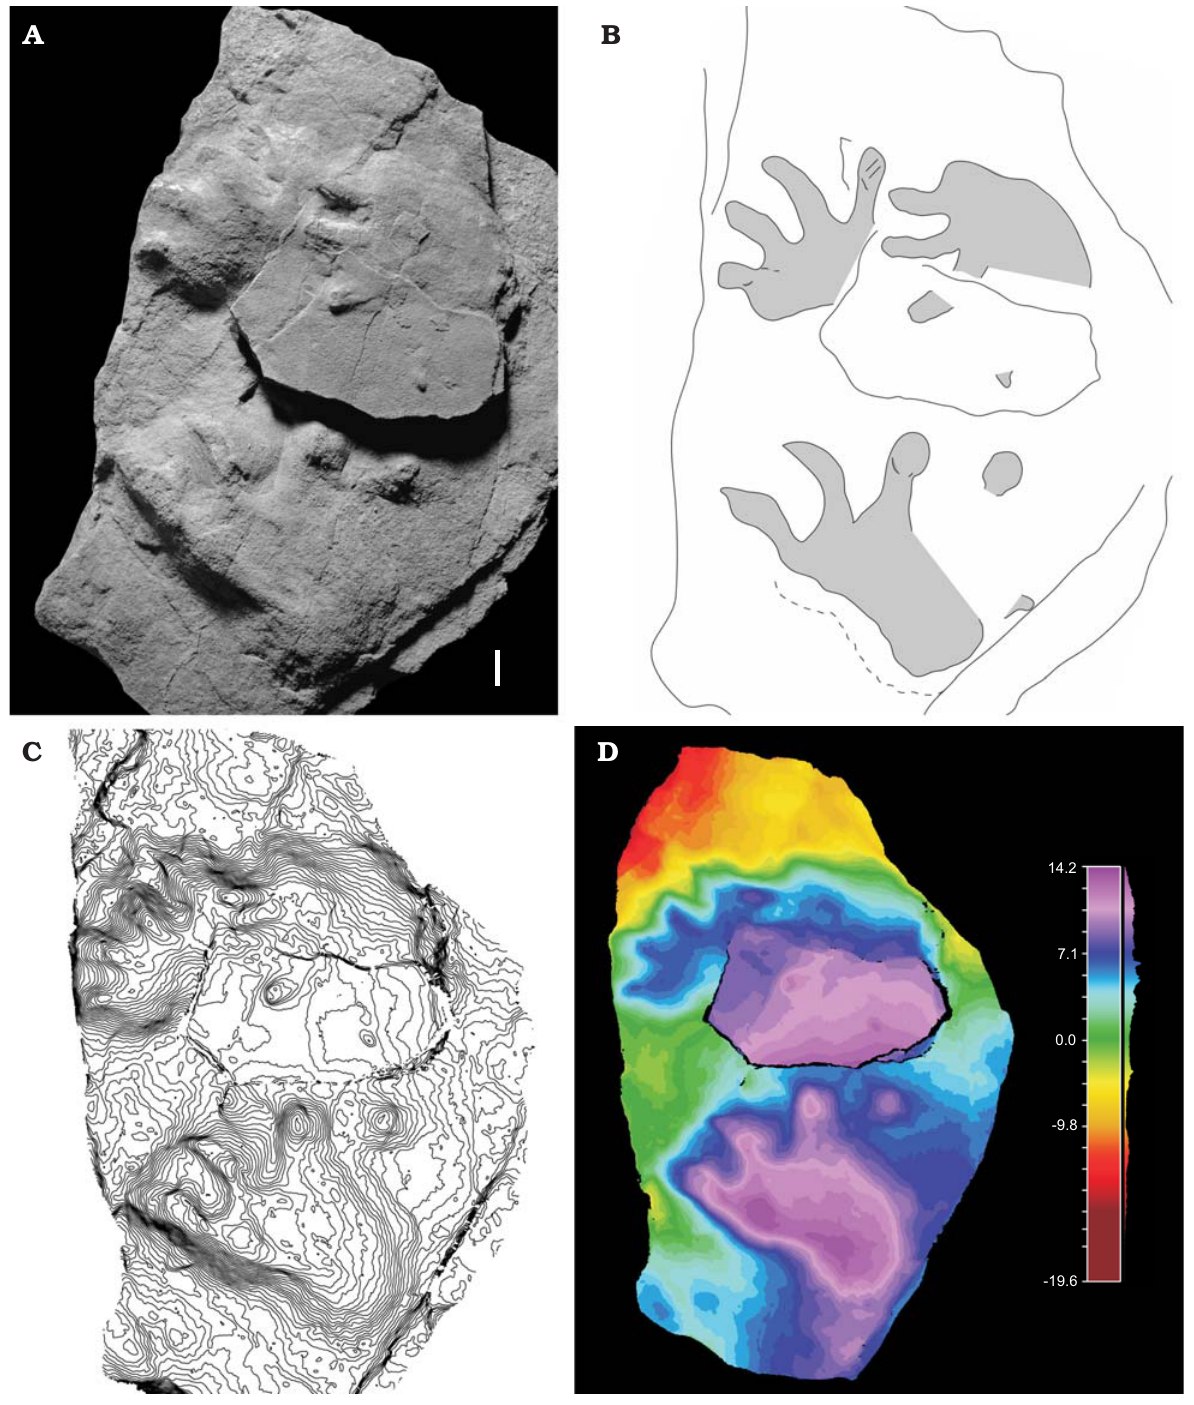
Fig. 4. Putative captorhinid trace cf. Merifontichnus isp. (MCV 2) from Ulbe (Italy), Lopingian. Left pes-manus couple and isolated right pes imprints, convex hyporelief. Photo ( A ), interpretive drawing ( B ), false-color depth map( C ), contour lines ( D ). Scale bar 10